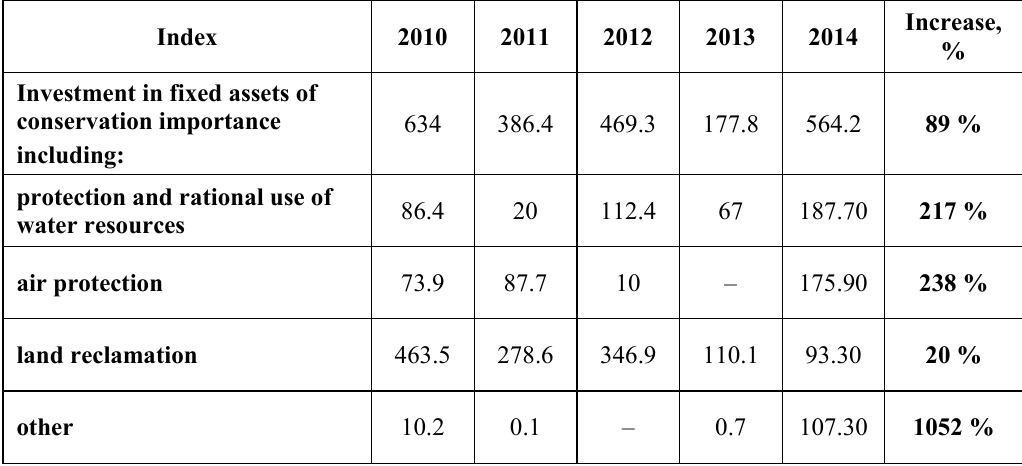
Table 1. The Dynamics of Investment in Fixed Assets of Conservation Importance for Saratov Region (unit is a million rubles) (Short Statistical